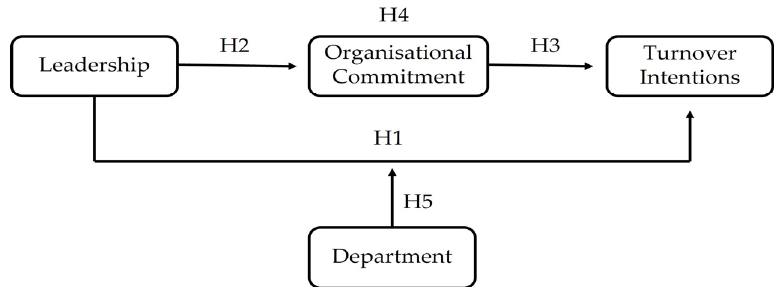
Figure 1. Research